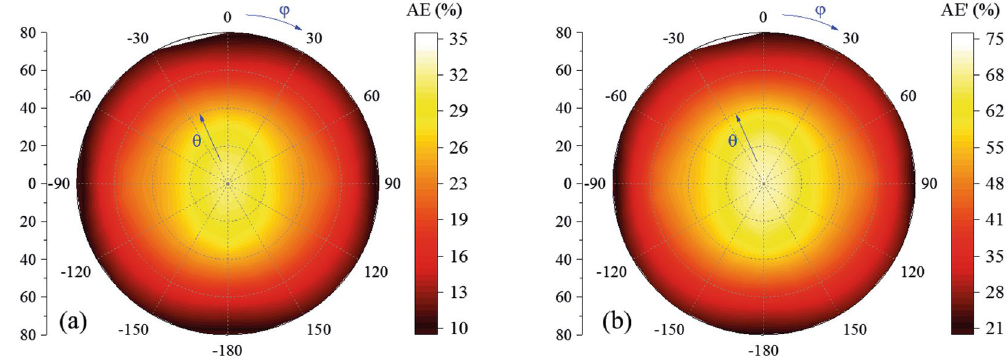
Figure 16. Aperture efficiency of the proposed planar array with 16 × 16 active elements. Aperture efficiencies calculated with and without dummy elements at different scanning angles are shown in ( a , b ),